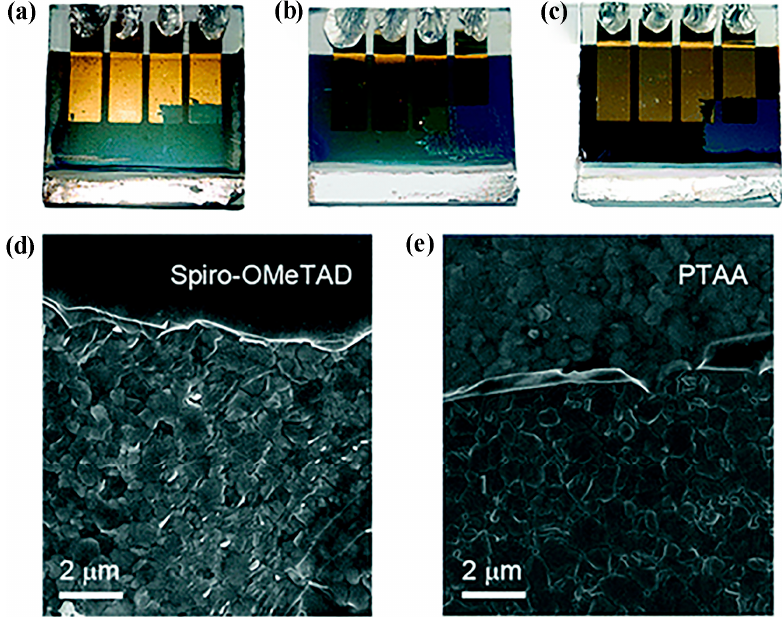
Figure 4. Images of cells after tape test. ( a ) Phthalocyanine-based device; only Au electrode was detached. ( b ) Spiro-OMeTAD-based device; spiro-OMeTAD HTL was partially detached. ( c ) PTAA- based device; PTAA HTL was totally detached. Scanning electron microscope (SEM) images of damaged regions of spiro-OMeTAD- ( d ) and PTAA- ( e ) based devices. Adapted with permission from Ref. [86]. Copyright 2017 The Royal Society of Chemistry.